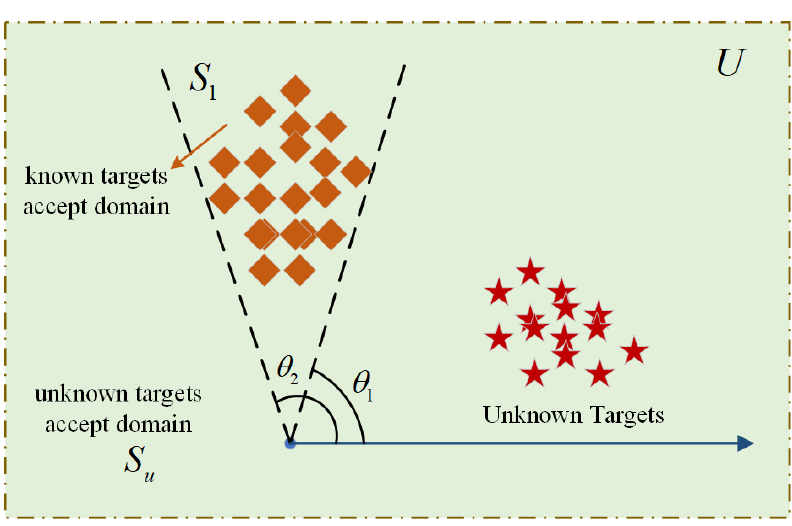
Figure 4. The principle of